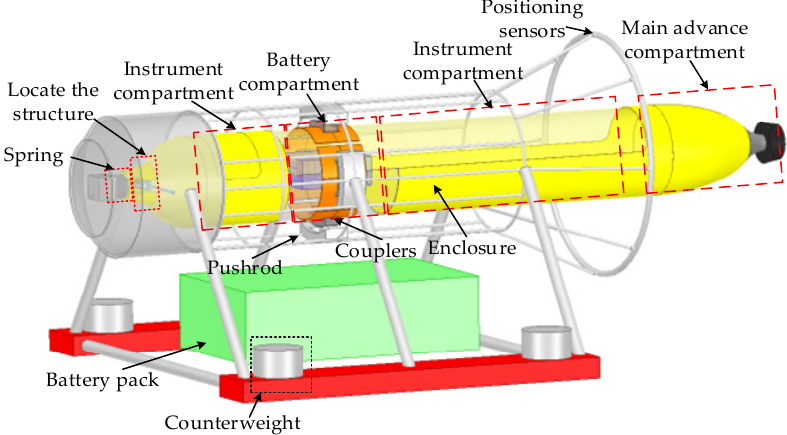
Figure 2. Overview of the cylindrical AUV and docking system.